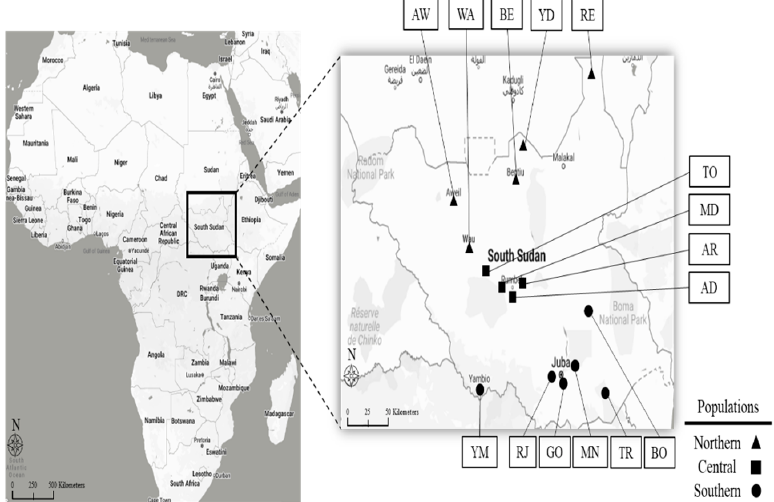
Figure 1. Maps showing geographic location of collection site of maize landrace populations sampled in South Sudan ( ● : maize population of southern region, ■ : maize population of central region, and ▲ : maize population of northern region). Refer to Table 1, for the full name of locations’ abbreviations used in the Figure 1.